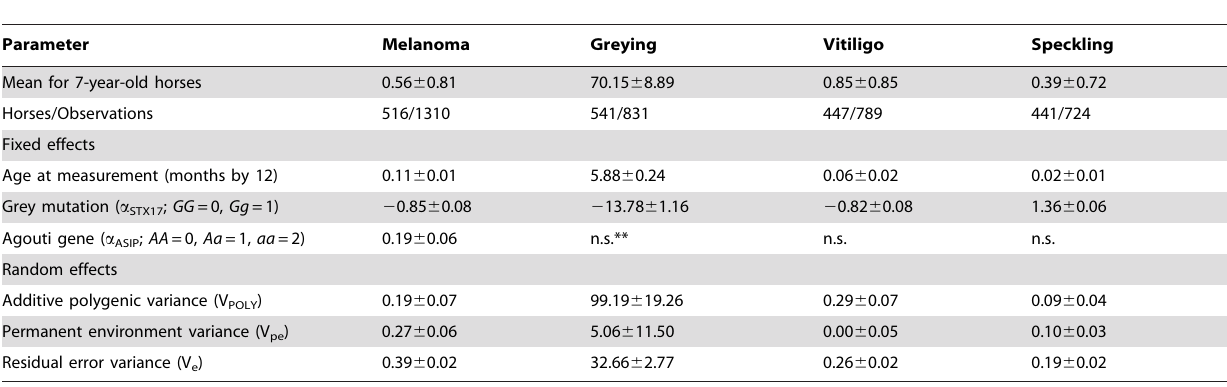
Table 1. Estimated fixed effects and variance components* for melanoma grade, grey level, vitiligo grade, and speckling grade.